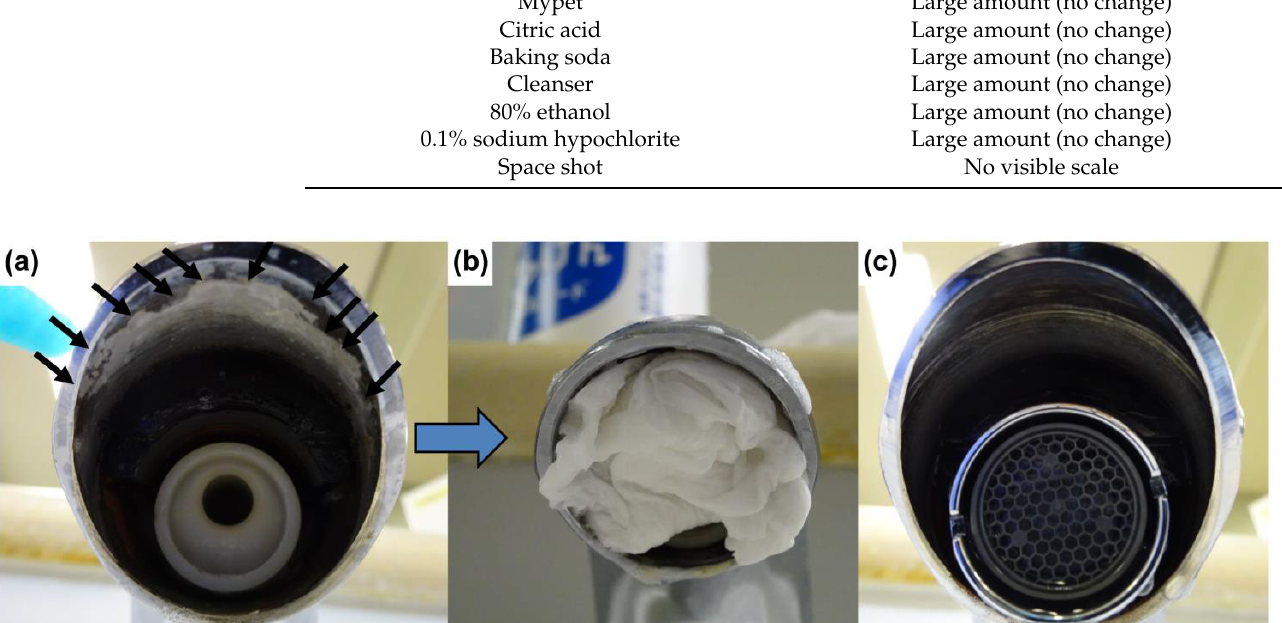
Table 2. Effectiveness of various detergents at removing hard scale around the washbasin tap. Table 3. Scale and bacteria detection status before and after cleaning around the washbasin tap with Space Shot detergent.